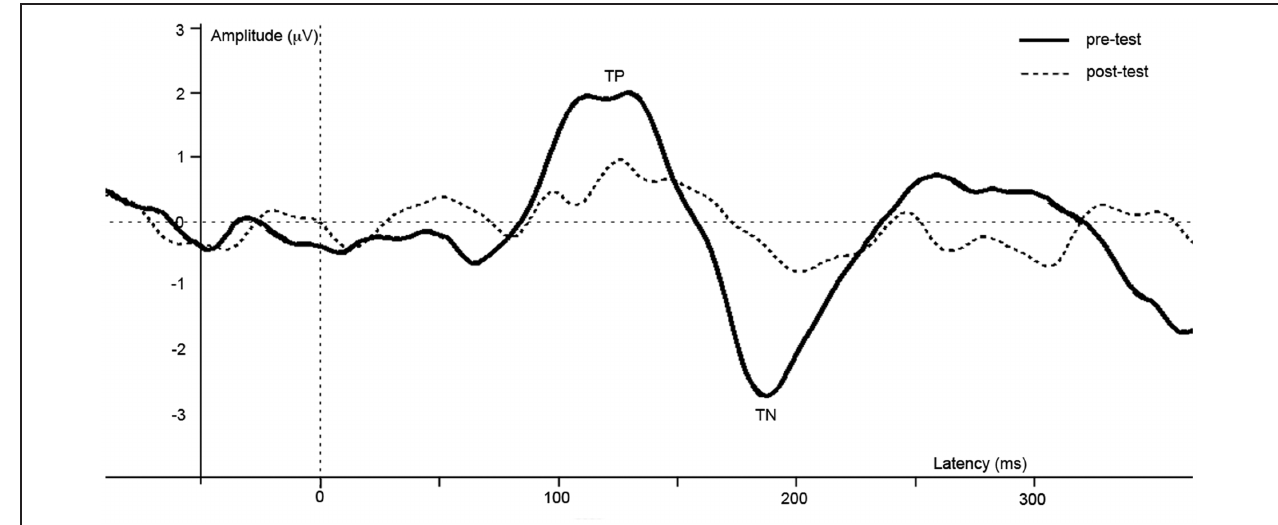
FIGURE 3 | Difference waves of grand averages at Oz electrode evoked by checkered vs. homogeneous stimuli in the pre-test (solid line) and post-test (dashed line) of the short-term study.